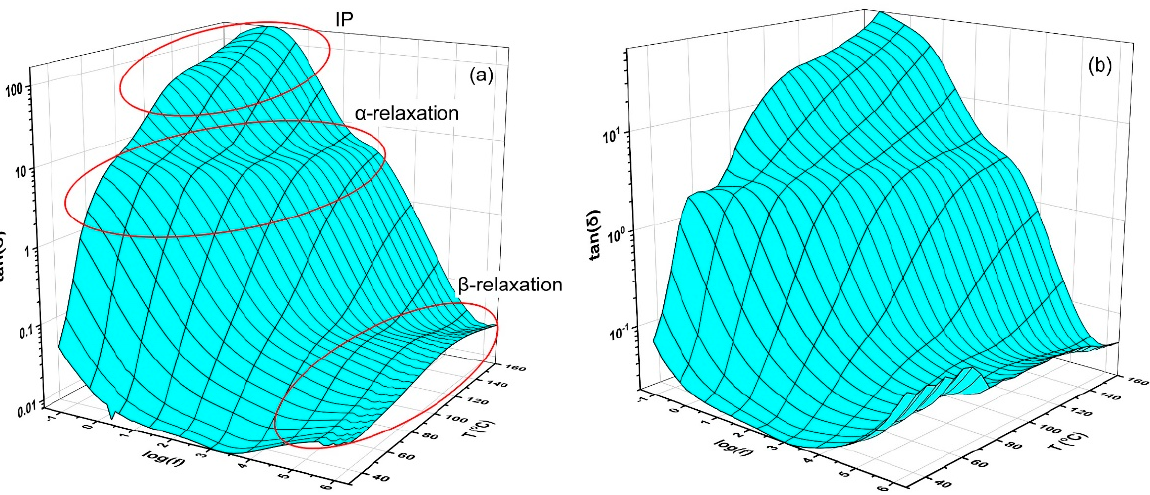
Figure 5. Loss tan δ as function of frequency and temperature for: ( a ) unfilled epoxy and ( b ) 5 phr TiC/5 phr BN/epoxy nanocomposite.